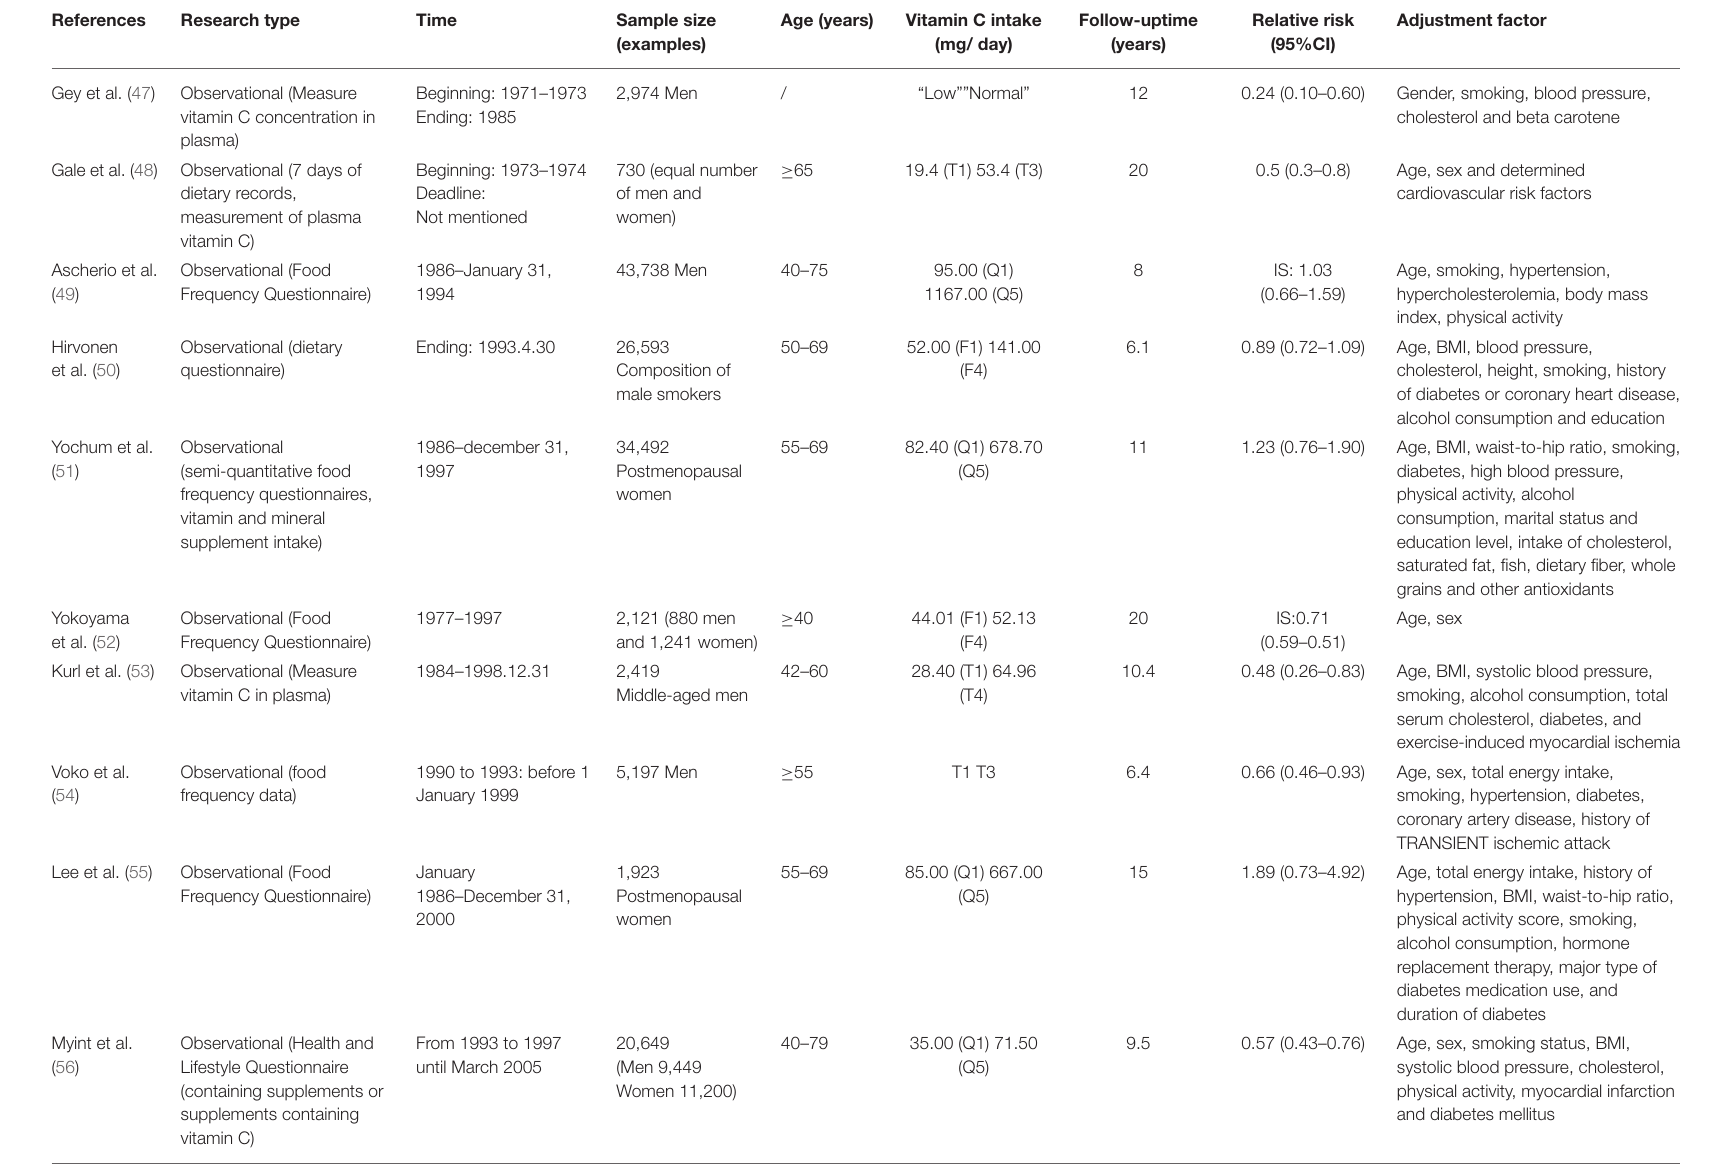
TABLE 1 | Cohort study of vitamin C and ischemic